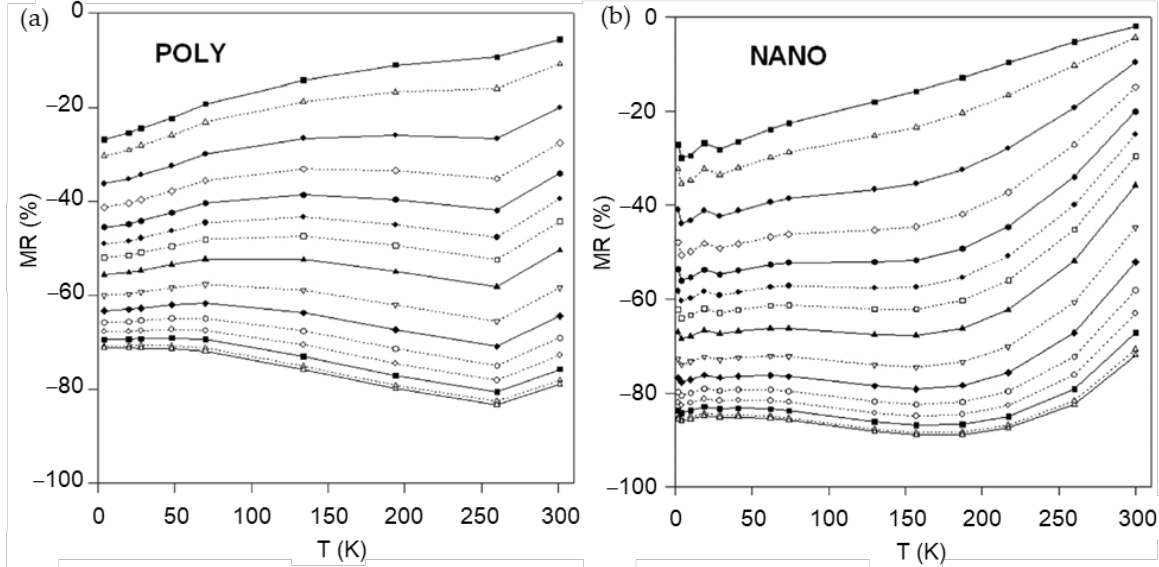
Figure 5. Temperature dependences of magnetoresistance for poly- ( a ); and nanocrystalline ( b ) man- ganites La 0.8 Sr 0.2 MnO 3 upon applied different magnetic fields: 1, 2, 4, 6, 8, 10, 12, 15, 20, 25, 30, 35, 40, 45, and 47 T (from top to bottom). Reprinted with permission from [54]. Copyright 2015 AIP Pub- lishing.